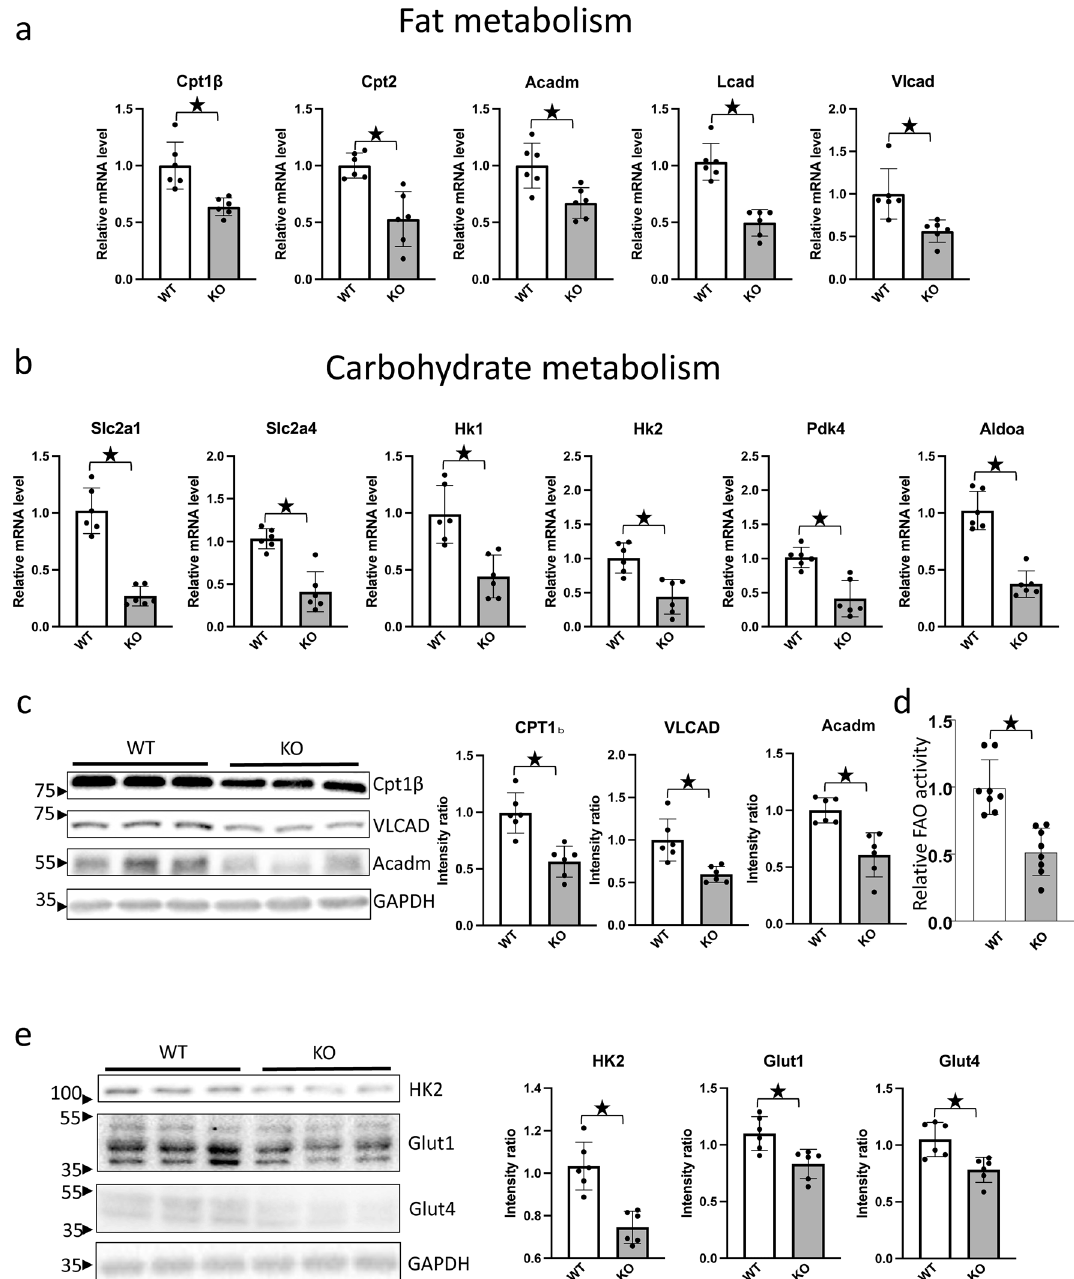
Figure 4. Perm1 knockout downregulated fat and carbohydrate metabolism-related proteins. ( a ) Expression levels of fat metabolism genes in Perm1 KO mice. Expression levels of the indicated fat metabolism genes were examined by RT-PCR. Samples were normalized by 15S gene expression, including Cpt1β, Cpt2, Mcad, Lcad, and Vlcad . The mean value from WT mice was expressed as 1 (N = 6), WT (3 male + 3 female); KO (3 male + 3 female), 2 months old. ( b ) Expression levels of carbohydrate metabolism genes in Perm1 KO mice. Expression levels of the indicated fat metabolism genes were examined by RT-PCR. Samples were normalized by 15S gene expression, including Slc2a1, Slc2a4, Hk1, Hk2, Pdk4, and Aldoa . The mean value from WT mice was expressed as 1 (N = 6), WT (3 male + 3 female); KO (3 male + 3 female), 2 months old. ( c ) Western blots showing CPT1β, VLCAD, and MCAD protein levels. The intensity was normalized by GAPDH (N = 6), WT (3 male + 3 female); KO (3 male + 3 female), 2 months old. ( d ) The heart lysate of WT and Perm1 KO mice were analyzed with a fatty acid oxidation (FAO) assay kit. The level of FAO was normalized by that in WT mice. WT (4 male + 4 female); KO (4 male + 4 female), 2 months old. ( e ) Western blots showing HK2, GLUT1, and GLUT4 protein levels. The intensity was normalized by GAPDH (N = 6), WT (3 male + 3 female); KO (3 male + 3 female), 2 months old. The statistical significance was determined with Student’s t test, *p < 0.05 was considered